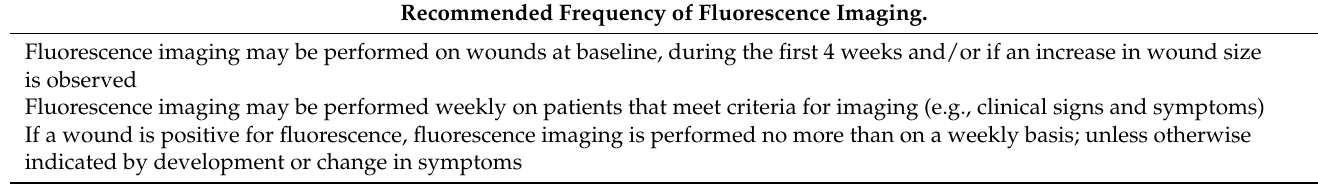
Table 5. Recommended frequency of fluorescence imaging. Recommended Frequency of Fluorescence